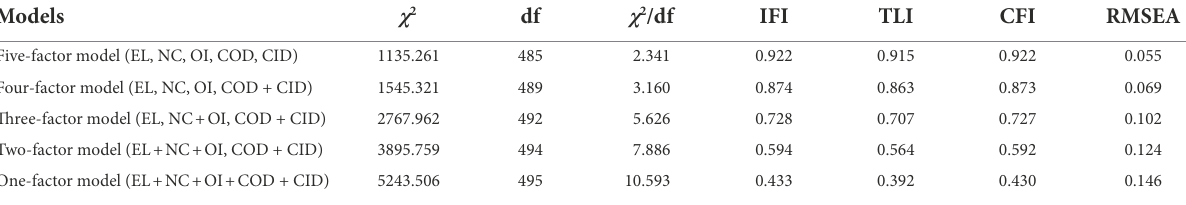
TABLE 4 Results of CFAs: comparison of measurement models.